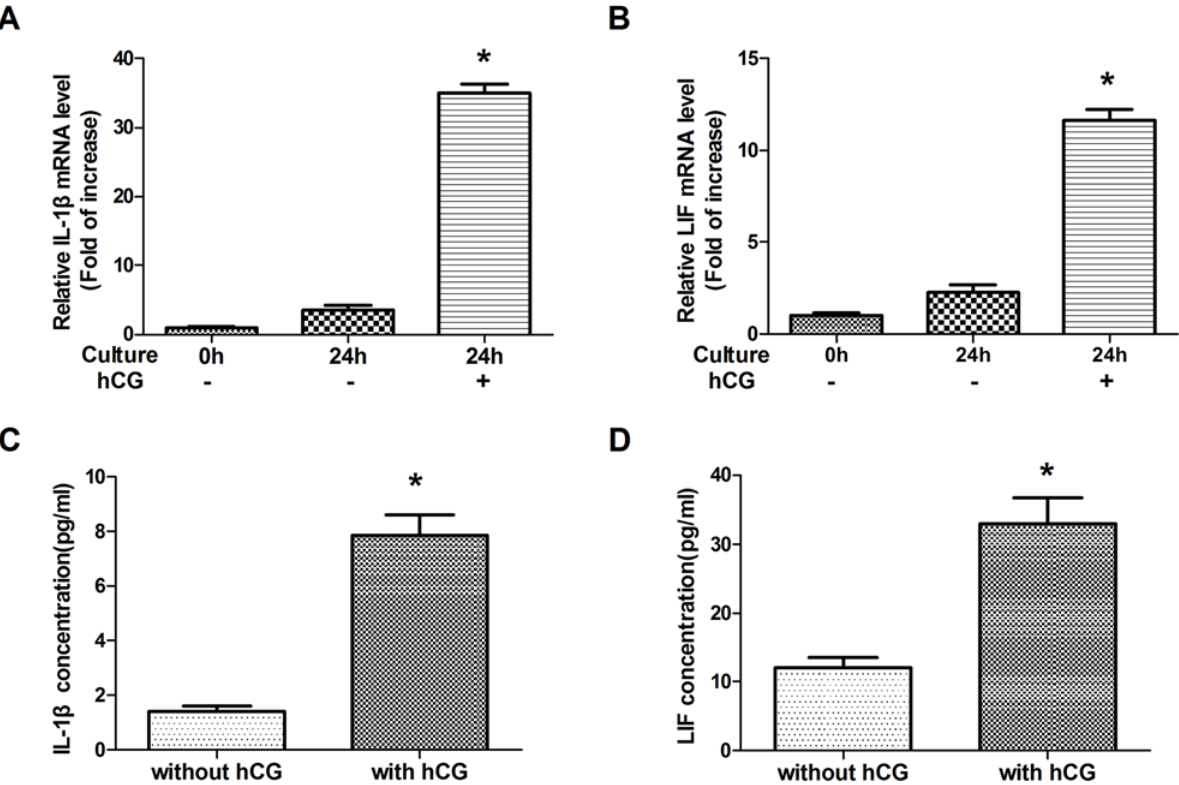
Fig 1. The effect of human chorionic gonadotropin (hCG) on the gene expression of interleukin (IL)-1 β and leukemia inhibitory factor (LIF) in peripheral blood mononuclear cells (PBMC) and the concentration of these cytokines in the medium of PBMC after 24-h culture. Changes in the relative amounts of IL-1 β (A) and LIF (B) mRNA in human PBMC cultured for 0 h (non-cultured) or 24 h. Data are expressed as mean ± standard error of the mean (SEM) of relative IL-1 β or LIF mRNA levels (fold of increase). * , P < 0.05 compared with the other two groups. IL-1 β (C) and LIF (D) secretion levels from PBMC were measured at 24 h after culturing with or without hCG. Data are presented as mean ± SEM of triplicate experiments. * , P < 0.05.